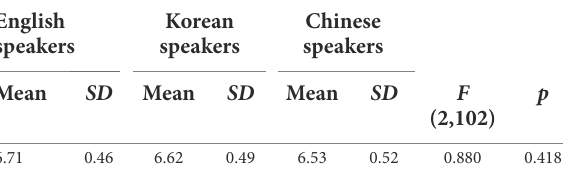
TABLE 2 Results of the backward digit span